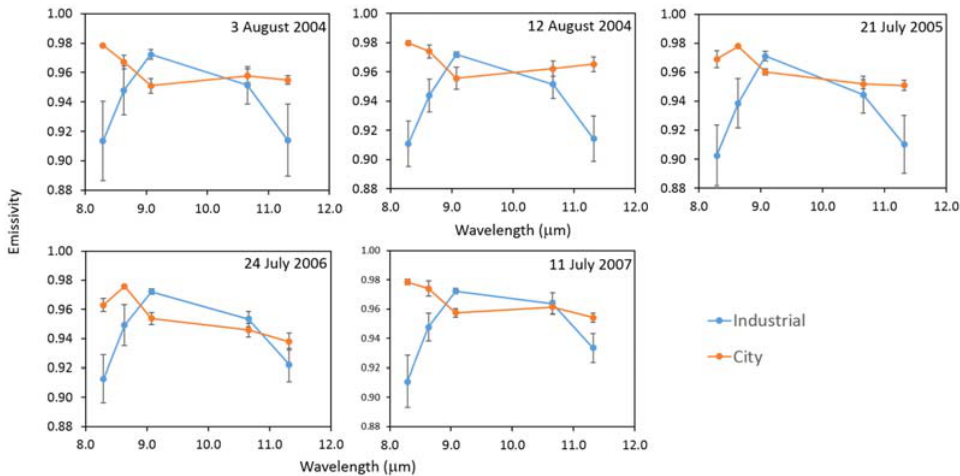
Figure 10. Scene over the study area on 3 August 2004 using TES emissivity from ASTER Channels 10 (8.29 µm), 12 (9.08 µm) and 14 (11.32 µm) to compose the RGB image, respectively.